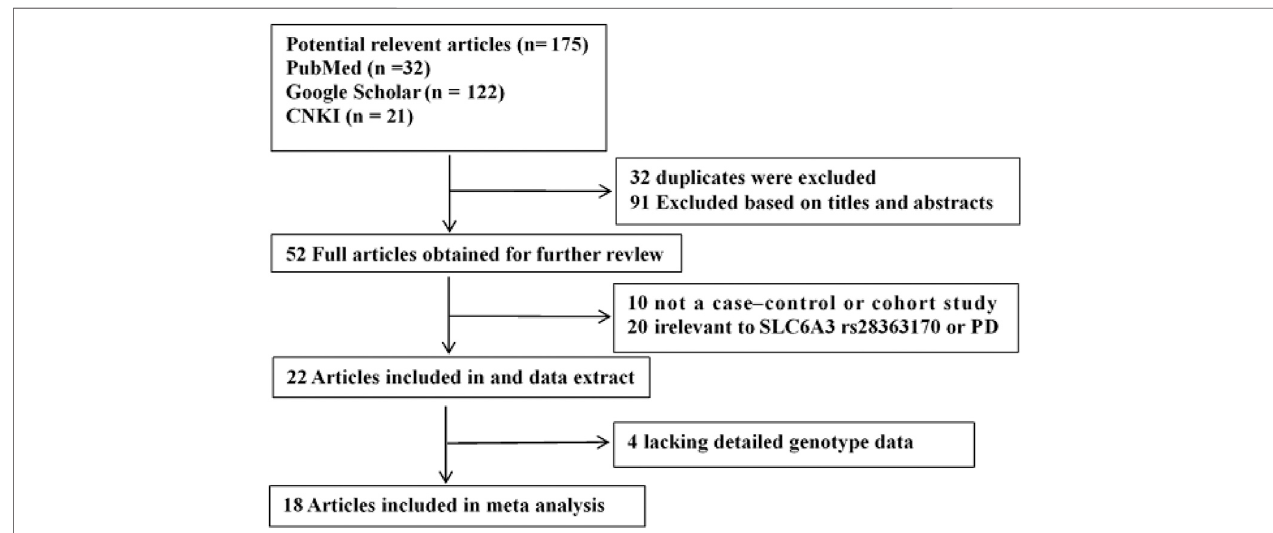
FIGURE 1 | Flow diagram of the literature search and